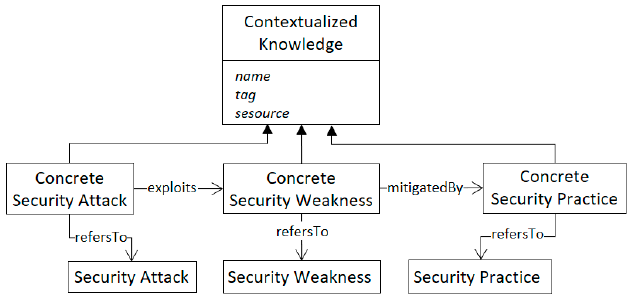
Figure 4. Security contextualization model.